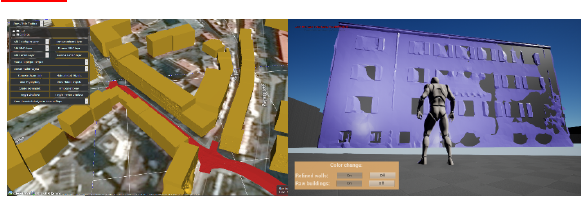
Figure 11. Refined models used in city models management tool (left) and automated driving simulator engine